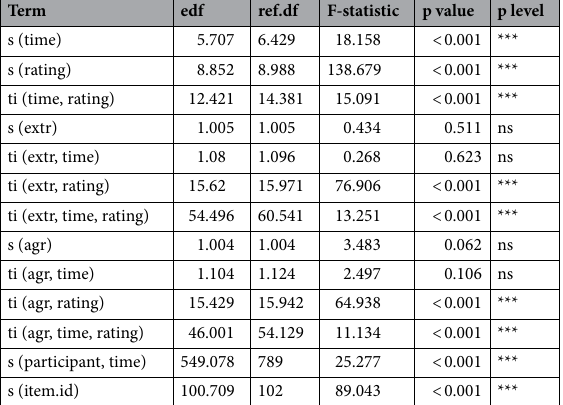
Table 8. Summary output for the combined GAMM modelling participants’ pupil sizes in response to semantic anomalies and with their Agreeableness and Extraversion scores as predictors.